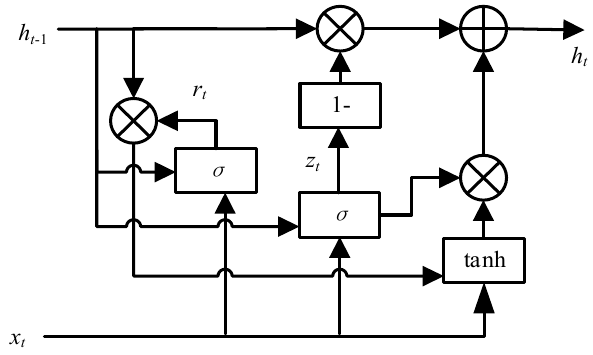
Figure 4. Gated circulation unit structure.